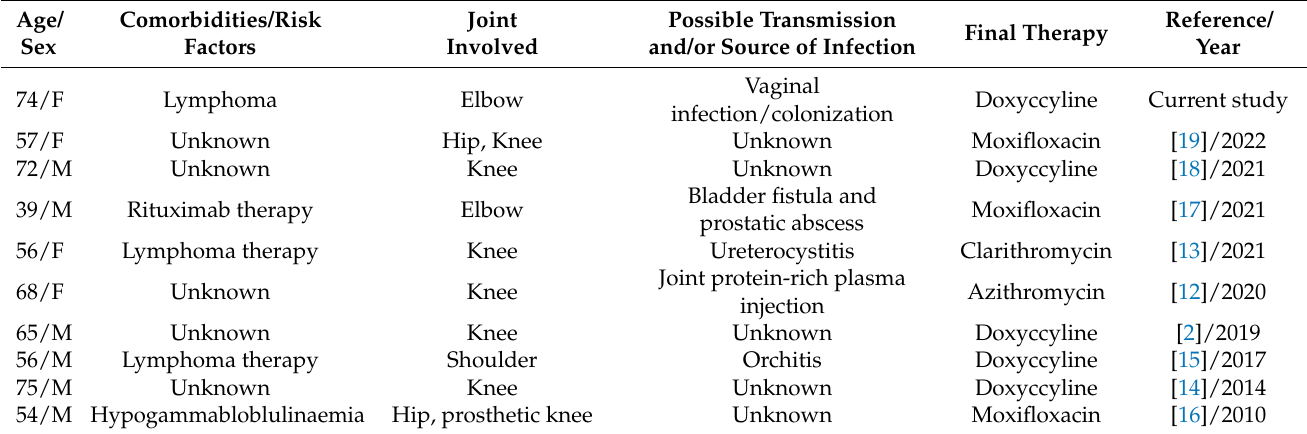
Table 1. Clinical features of patients with septic arthritis caused by Ureplasma parvum